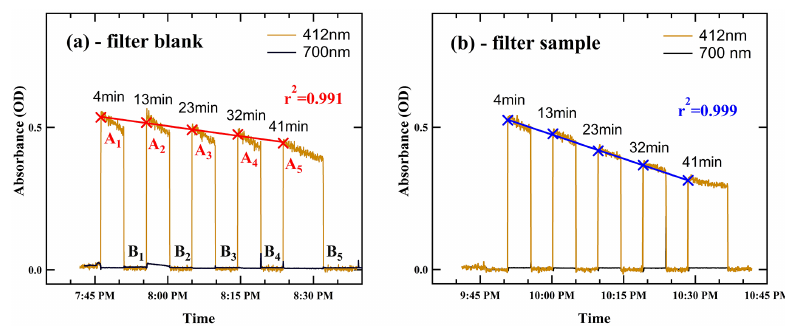
Figure 3. Example of an absorbance plot for a filter blank (a) and an ambient aerosol sample (b) .